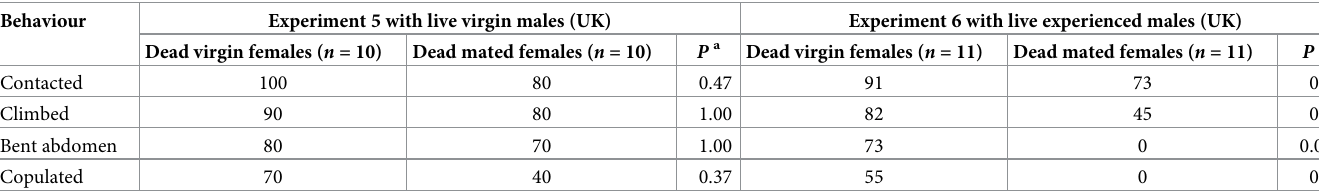
Copulated 70 40 0.37 55 0.01 ‘Experienced males’ and ‘experienced females’ had been exposed to high densities of males and females. ‘Mated females’ were the same age and from the same cohort as the ‘virgin females’ in the same experiment, but had been mated once with a virgin male. a P -values were calculated using Fisher’s exact test for a 2 x 2 contingency table with the frequencies of pairs that did or did not exhibit the behaviour against whether the dead female was virgin or